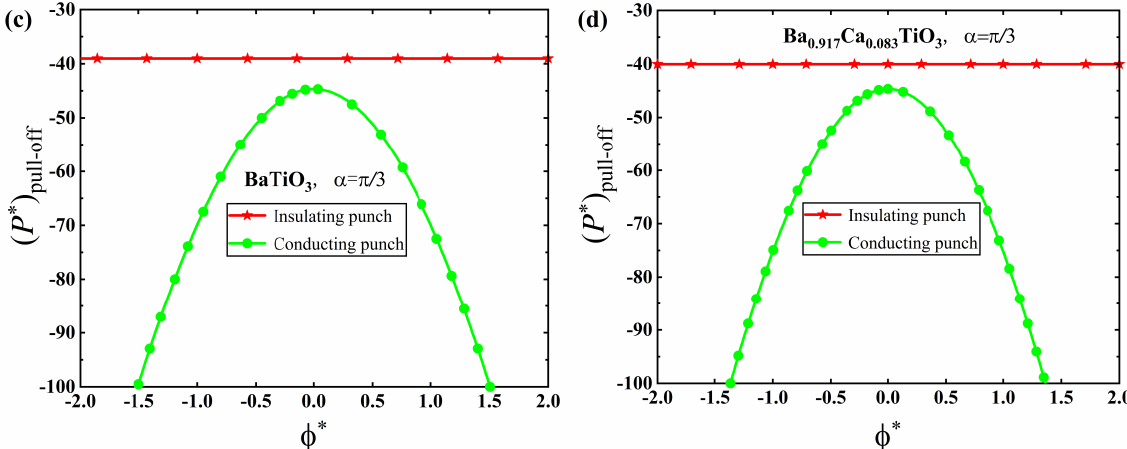
Figure 12. Variation of the dimensionless pull-off force, P ∗ pu ll - o ff potential, φ ∗ , at a fixed value of α = π /3. ( a ) PZT-4. ( b ) PZT-5A. ( c ) BaTiO 3 . ( d ) Ba 0.917 Ca 0.083 TiO 3 .